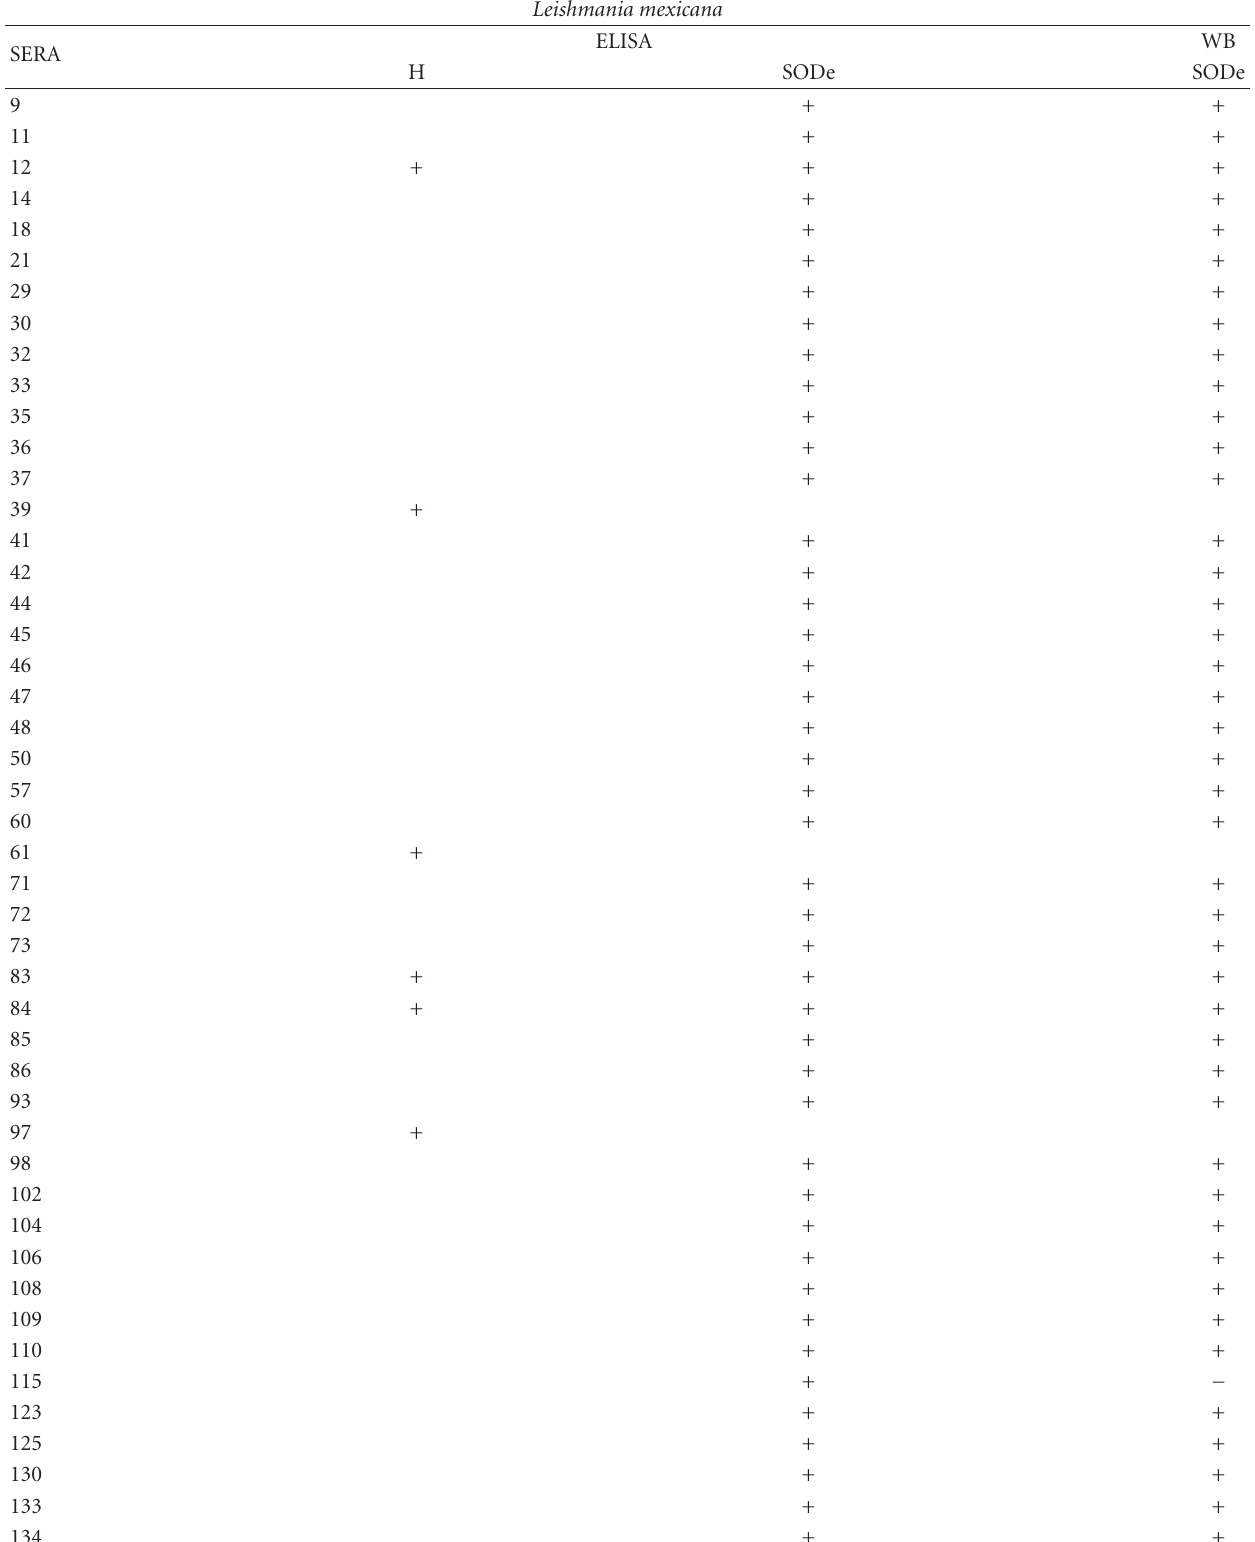
Table 4: The relationship of positive sera of dogs from the Peninsula of Yucatan (Mexico) with Trypanosomatids by ELISA and Western blot analysis against di ff erent antigen fractions of Leishmania mexicana .